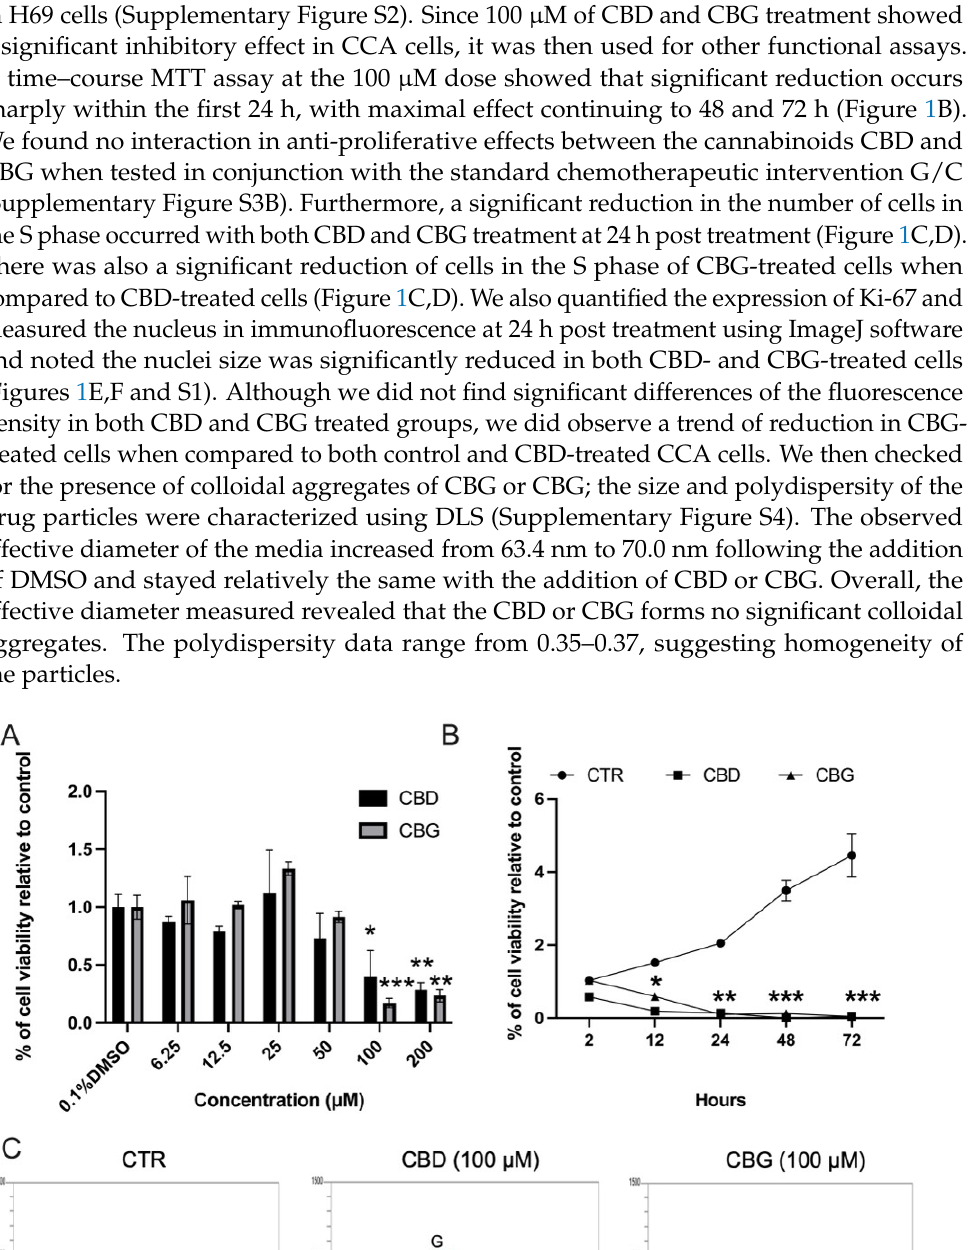
Figure 1. CBD and CBG treatment reduced proliferation in HuCC-T1 cells: ( A ). MTT assay results showing cell viability in HuCC-T1 48-h post treatment with control (0.1% DMSO), CBD or CBG; ( B ). time–course MTT assay at 100 μ M established dose over a 72-h time period; ( C ). propidium iodide histogram showing cell cycle doublet shown; population in each group (Sub G0, G0,S,G2/M) shown; ( D ). percentage of each cell cycle population in each treatment was quantified, n = 3; ( E , F ). quantifi- cation of Alex Fluor 488 staining of Ki-67 (green) and DAPI staining of nuclei size; ( E ). and fluores- cence intensity; ( F ). in all three groups with a significant decrease in the size of the nucleus; ( F ). CTCF: corrected total cell fluorescence. * P < 0.05 vs. 0.1% DMSO or CTR; ** P < 0.01 vs. 0.1% DMSO or CTR; *** P < 0.001 vs. 0.1% DMSO or CTR . 3.2. Cannabinoids Prevented Wound Closure and Attenuated Migration In the scratch migration assay, both CBD and CBG treatment significantly reduced the rate of wound closure at the 18-h and 24-h time points (Figure 2A,C). A significant reduction of migrated cells was shown in both CBD and CBG treated groups, with even more reduction occurring with CBG treatment when compared to CBD (Figure 2B,D). In the colonogenic formation assay, a significant reduction in the number and size of colonies was observed only in CBG treatment (Figure 2E–G).